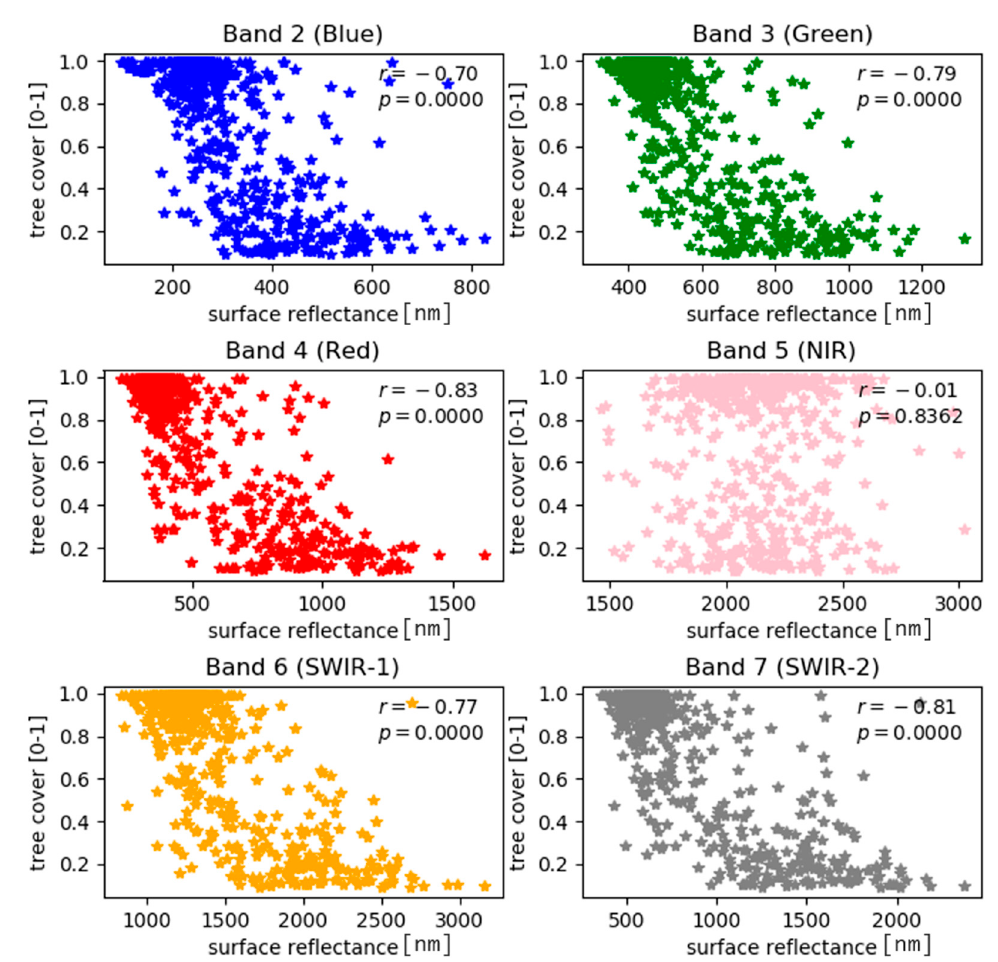
Figure 2. Scatterplot of band-wise Landsat surface reflectance values (scale factor 0.001) against tree cover per pixel, where 0 equals 0% and 1 equals 100%.